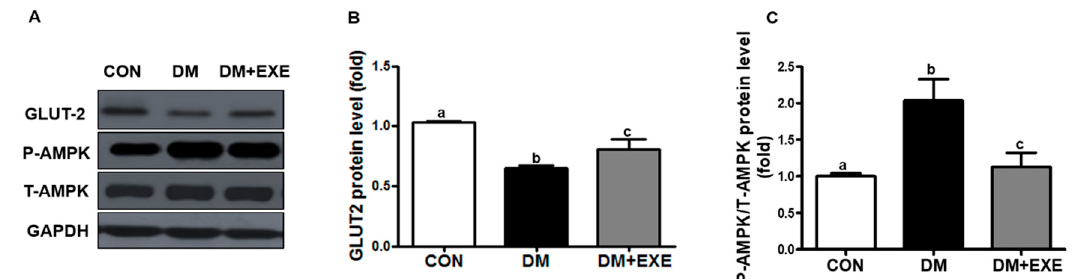
Figure 4. Resistance exercise training increased GLUT2 and attenuated AMPK protein levels in the hypothalamus of T2DM rats. All data are presented as the Mean ± SD. ( A ) representative western blotting band, ( B ) glucose transporter 2 (GLUT2), ( C ) phosphorylation-adenosine monophosphate-activated protein kinase (P-AMPK)/total-adenosine monophosphate-activated protein kinase (T-AMPK). CON: non-diabetic control group; DM: diabetic control group; DM + EXE: diabetic with resistance exercise training group. a, b, c Different letters indicate a significant difference between groups ( p < 0.05).